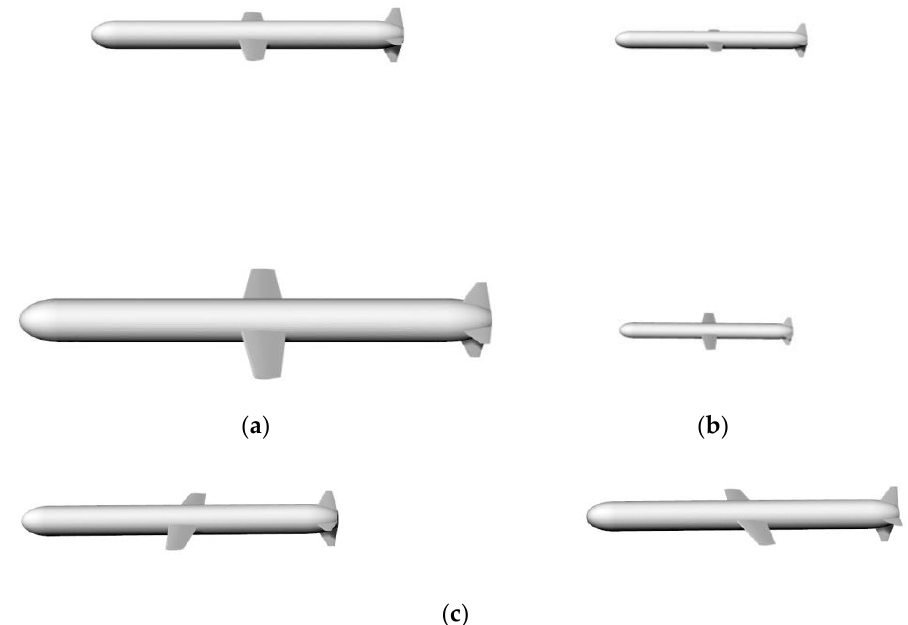
Figure 5. The location distribution of the missile−like targets: ( a ) at the same height above the rough sea surface and parallel to each other; ( b ) at a different height above the rough sea surface and parallel to each other; ( c ) at the same height above the rough sea surface and in a tandem array.